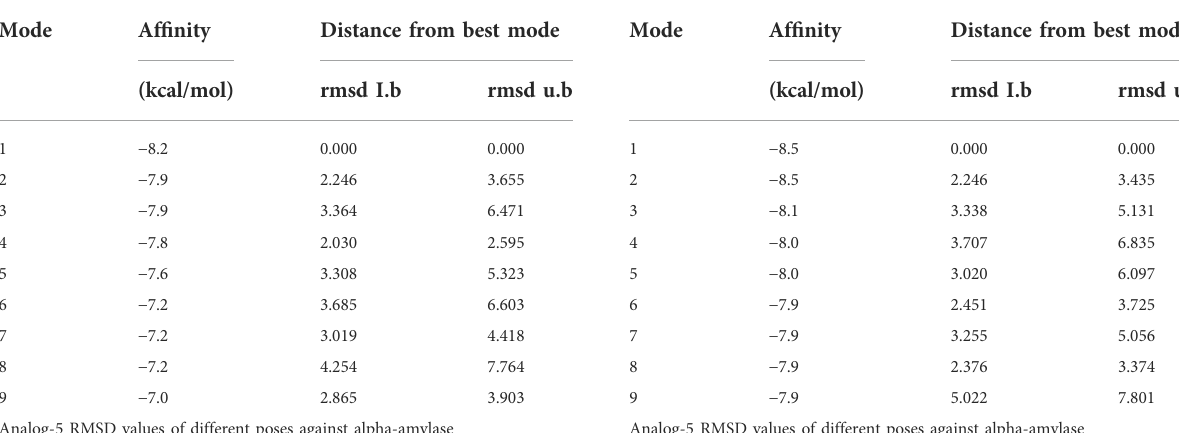
TABLE 2 RMSD values of different poses of analog 11d against α - amylase and α -glucosidase